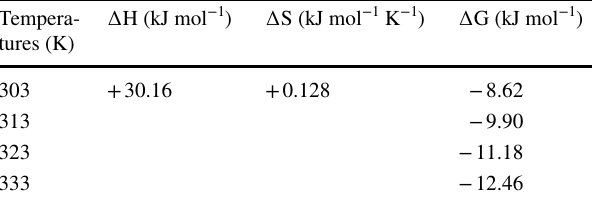
Table 6 Data for estimating the thermodynamic parameters for adsorption of methylene blue on coconut coir dust Tempera- tures